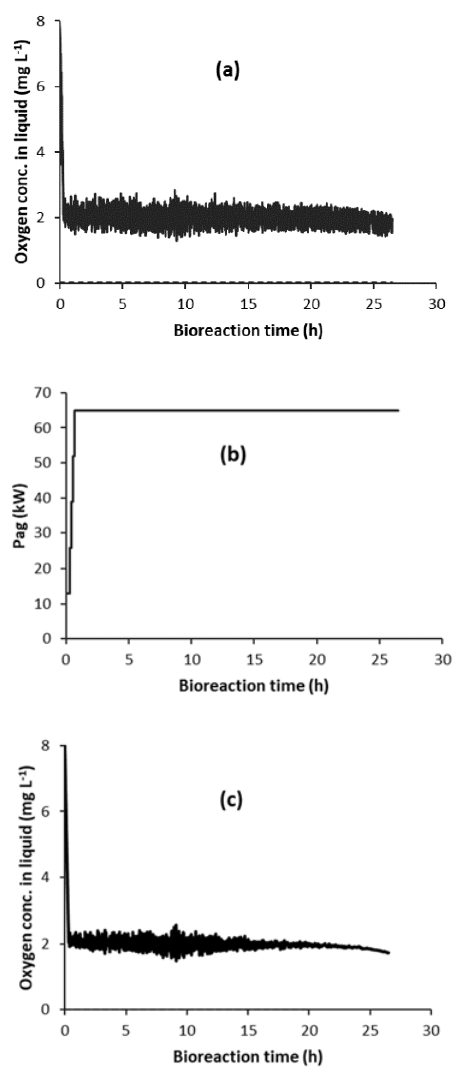
Figure 7. ( a ) Random fluctuation ( Y = 0.2) of sensor oxygen concentration in liquid ( C OL_sensor ), and its e ff ect on the evolution of ( b ) Pag , and ( c ) C OL for control strategy C1 F -5 (with automatic detection of effect on the evolution of ( b ) Pag , and ( c ) C OL for control strategy C1 F ‐ 5 (with automatic detection of flooding; C OL_FLD = 1.9 mg L − 1 flooding; C OL_FLD = 1.9 mg L − 1 ).